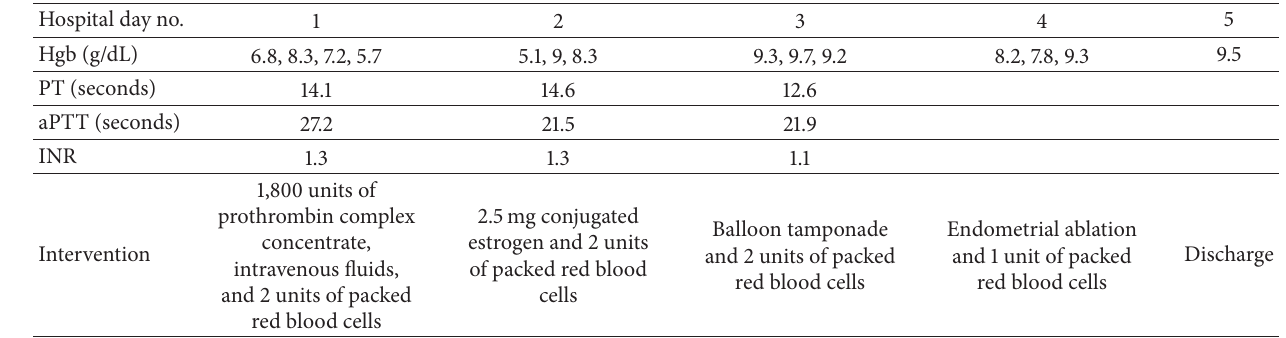
Table 1: Timeline of